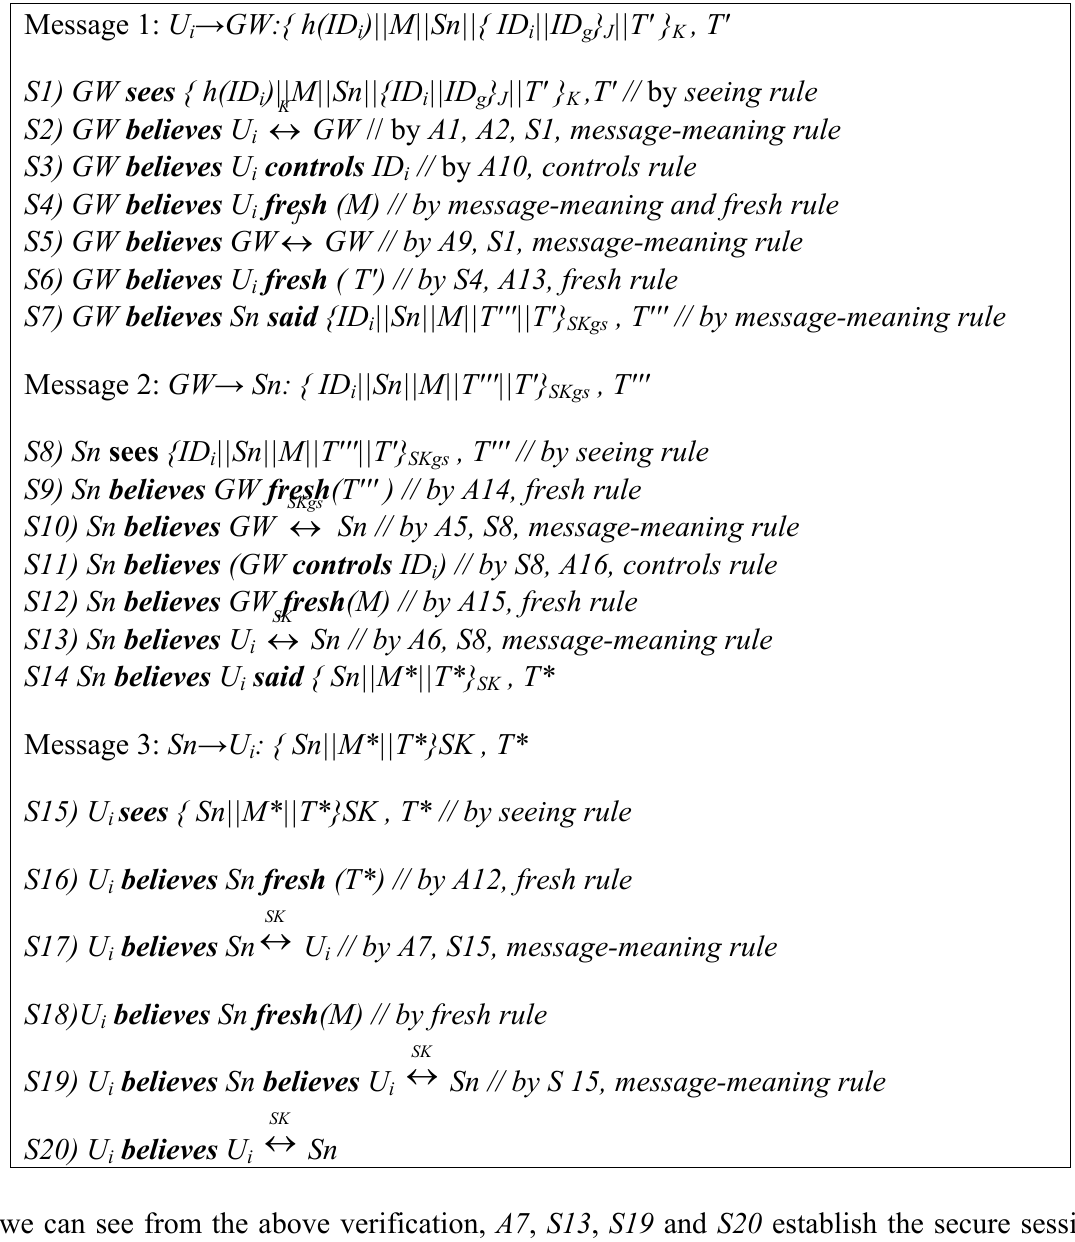
Table 3. Formal verification of E-SAP using BAN logic